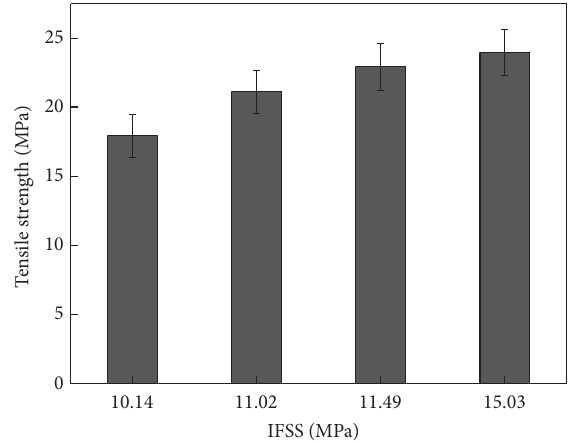
Figure 13: Relationship between tensile strength and IFSS of the kenaf/SPI-PVA